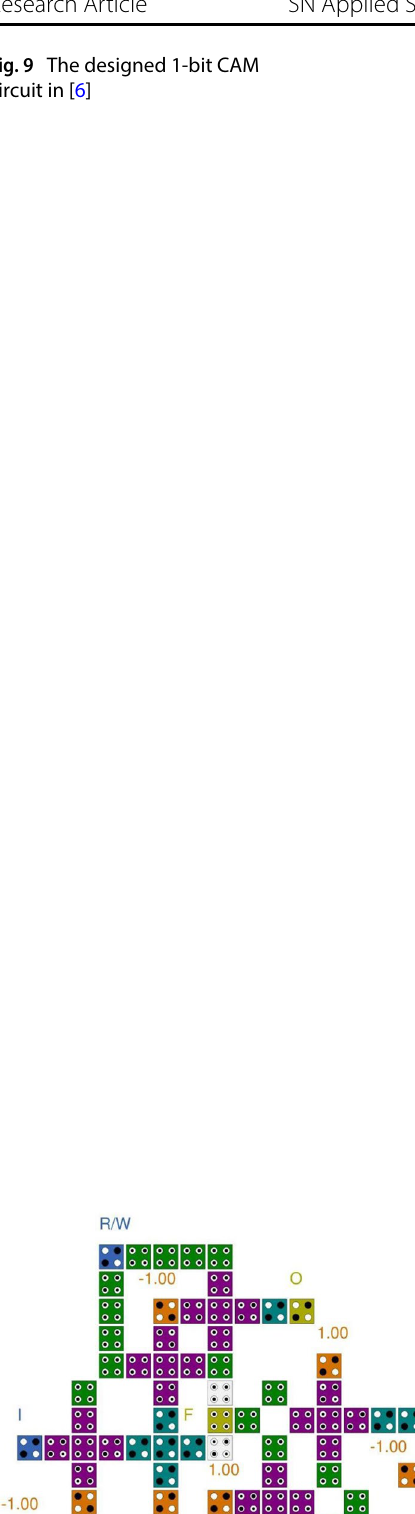
Fig. 11 The designed 1-bit CAM circuit in